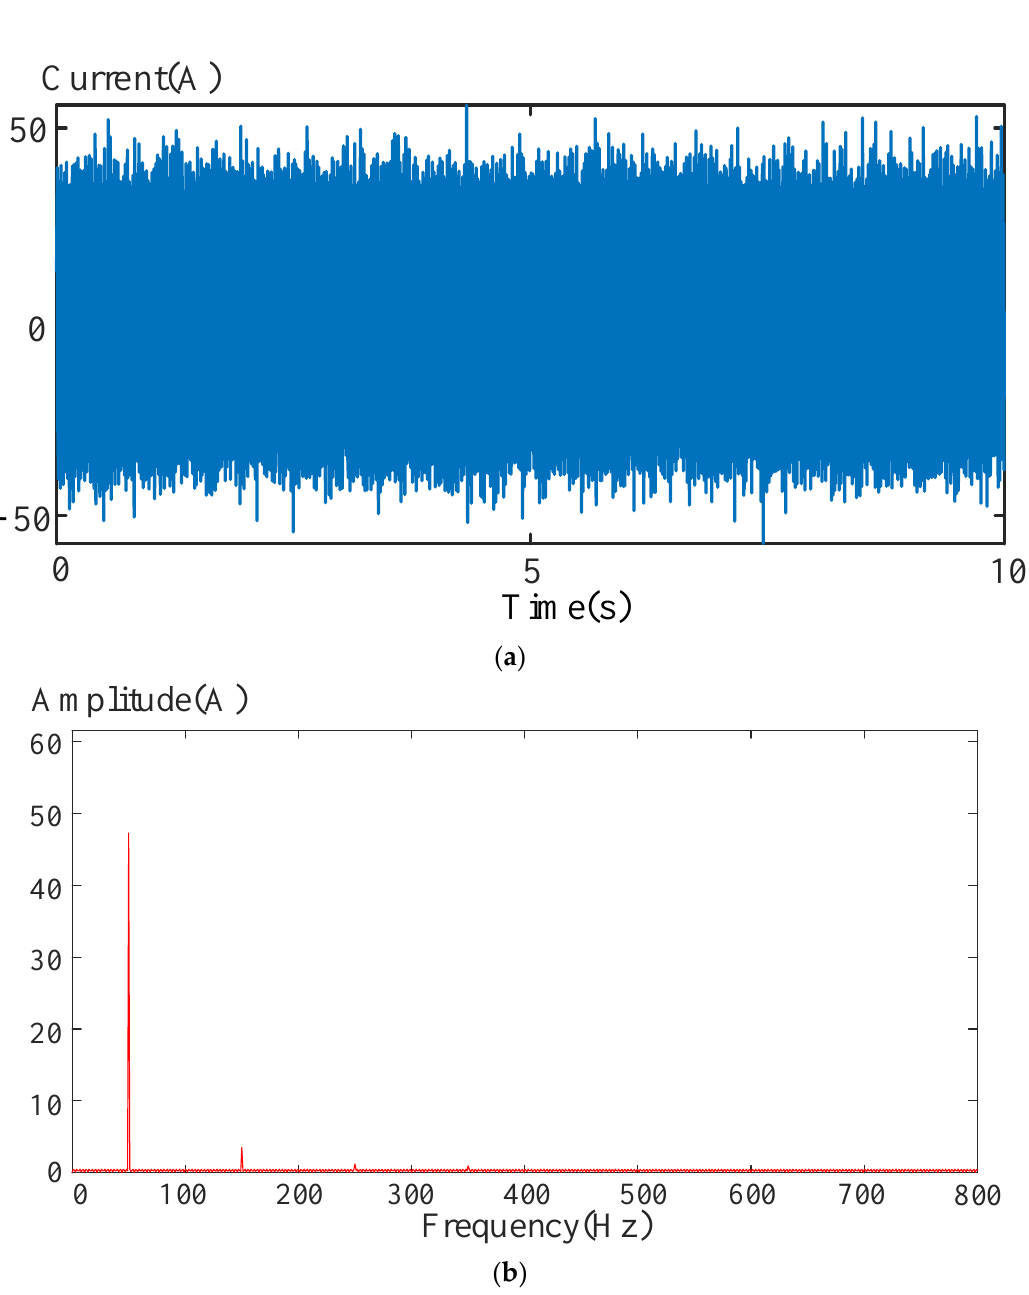
Figure 5. ( a ) Current recorded data. ( b ) spectrum.